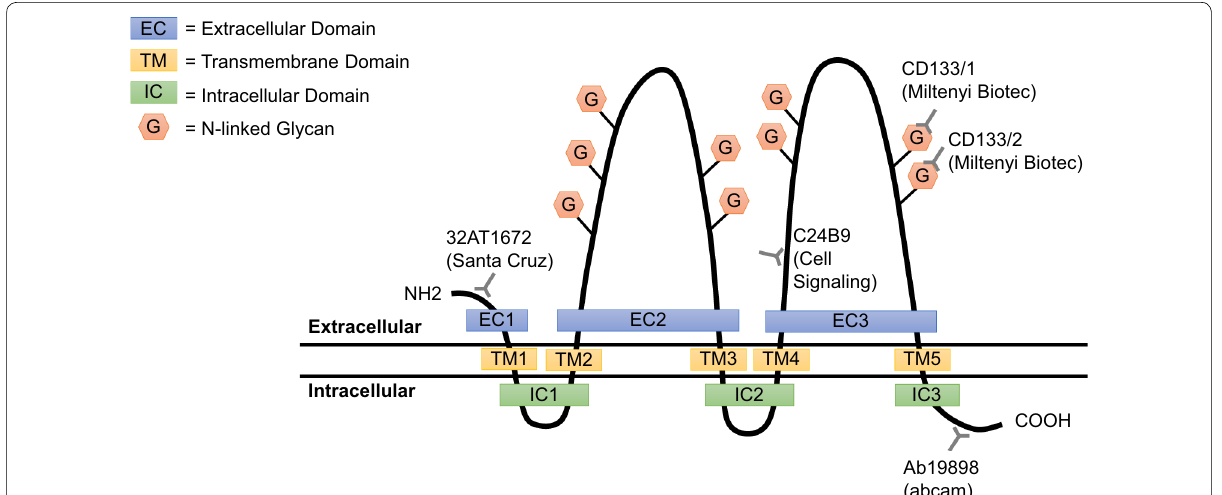
Fig. 1 Schematic of the CD133 topology and putative epitopes of commercially available CD133 antibodies. The five transmembrane glycoprotein contains two large extracellular loops (EC2 and EC3), which comprise a total of nine N‑linked glycan residues. The commonly used CD133/1 and CD133/2 epitopes are located on the EC3 region of CD133 and have the potential for epitope masking or antibody inaccessibility due to changes in glycosylation